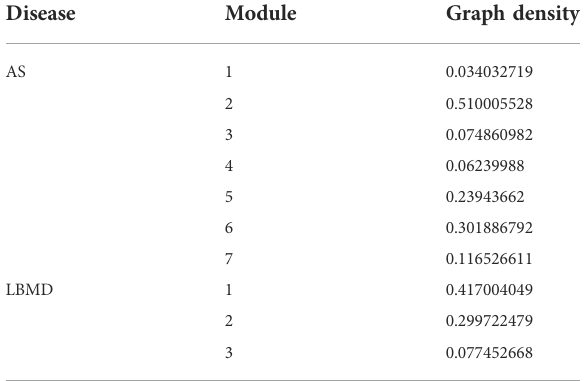
TABLE 2 The density of each